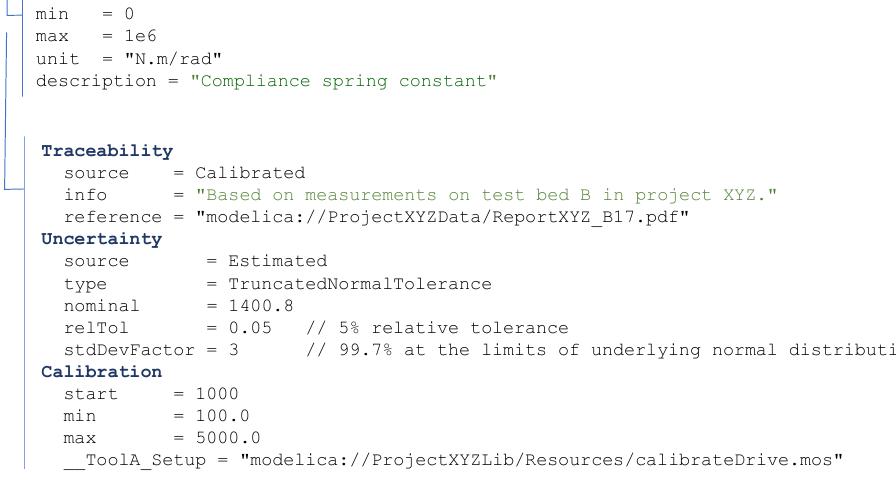
Figure 2. Example of the structure of the parameter record for a scalar parameter c